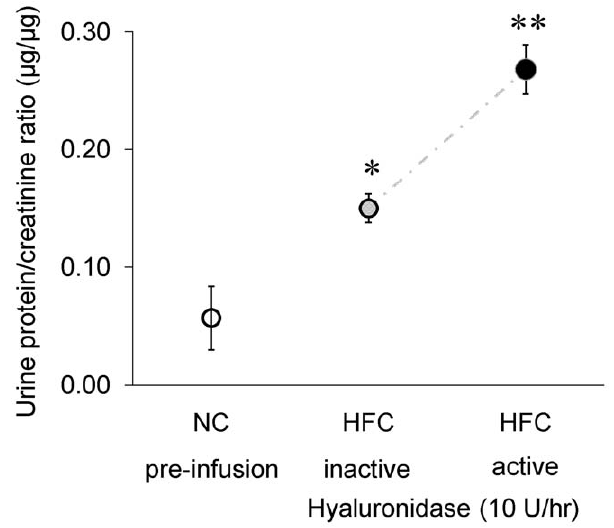
Figure 4. Renal protein leakage of apoE 2 / 2 mice on normal chow (NC) or on a Western-type atherogenic diet (HFC) for 10 weeks or in combination with active- or inactive hyaluronidase infusion, given as protein/creatinin excretion ratio ( m g/ m g). Values are means 6 SD from end-point urine samples. Difference in protein/creatinin ratio was assessed by means of two-sample t -test (2- way). * P , 0.05 of apoE 2 / 2 on HFC and inactive hyaluronidase vs. apoE 2 / 2 on NC; ** P , 0.05 of apoE 2 / 2 on HFC and active hyaluronidase vs. apoE 2 / 2 on NC or apoE 2 / 2 on HFC and inactive hyaluronidase.